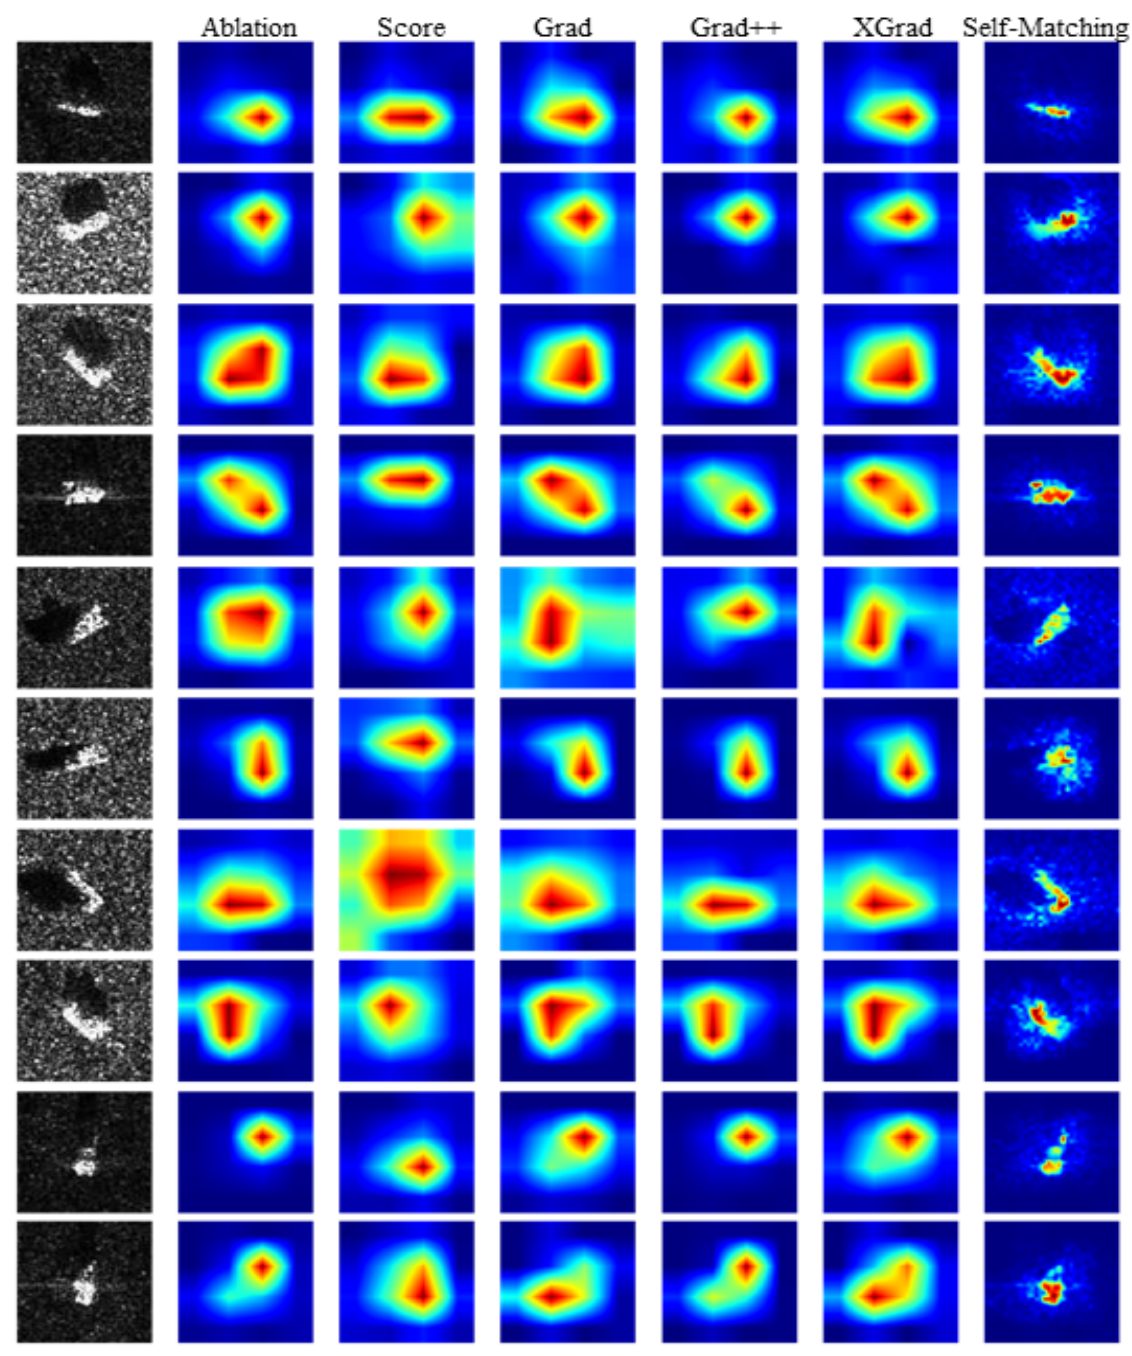
Figure 3. Comparison of various CAM methods for MTSTAR SAR images. The ten rows denote vehicles of different classes: 2S1, BRDM_2, BTR_60, D7, SN_132, SN_9563, SN_C71, T62, ZIL131, and ZSU_23_4. The seven columns denote Ablation-CAM, Score-CAM, Grad-CAM, Grad-CAM++, XGrad-CAM, and Self-Matching